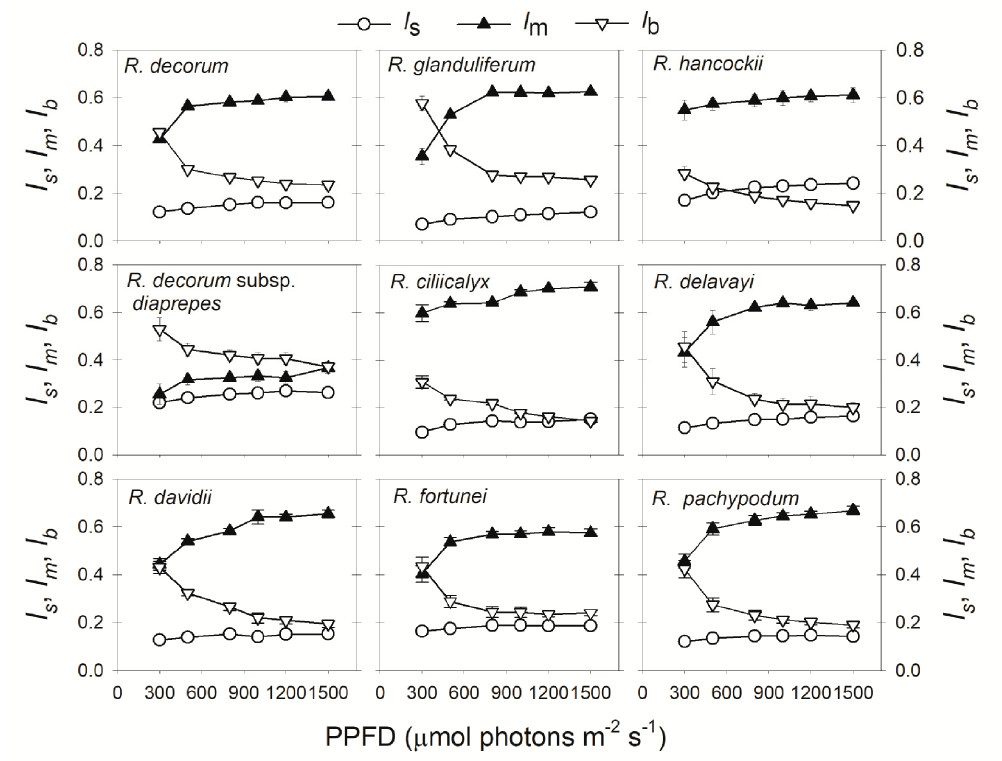
Figure 2. Response of mesophyll conductance ( g m ) to incident light intensity in nine Rhododendron species. The average g m values across light response curves in these nine Rhododendron species are displayed with the symbols. Symbols represent means ± SE ( n = 4–5). Species abbreviations: DEC, R. decorum ; GLA, R. glanduliferum ; HAN, R. hancockii ; DED, R. decorum subsp. disprepes ; CIL, R. ciliicalyx ; DEL, R. delavayi ; DAV, R. davidii ; FOR, R. fortunei ; PAC, R. pachypodum .